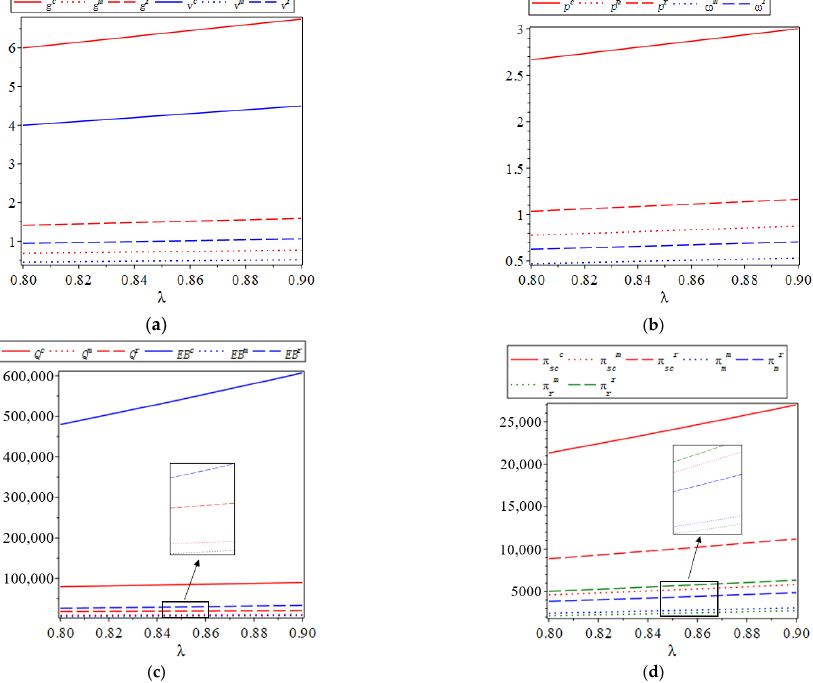
Figure 2. Decisions, demand, profits, and environmental benefit change with λ . ( a ) Greenness and targeted advertising intensity change with λ . ( b ) Prices change with λ . ( c ) Demand and environmental benefit change with λ . ( d ) Profits change with λ .